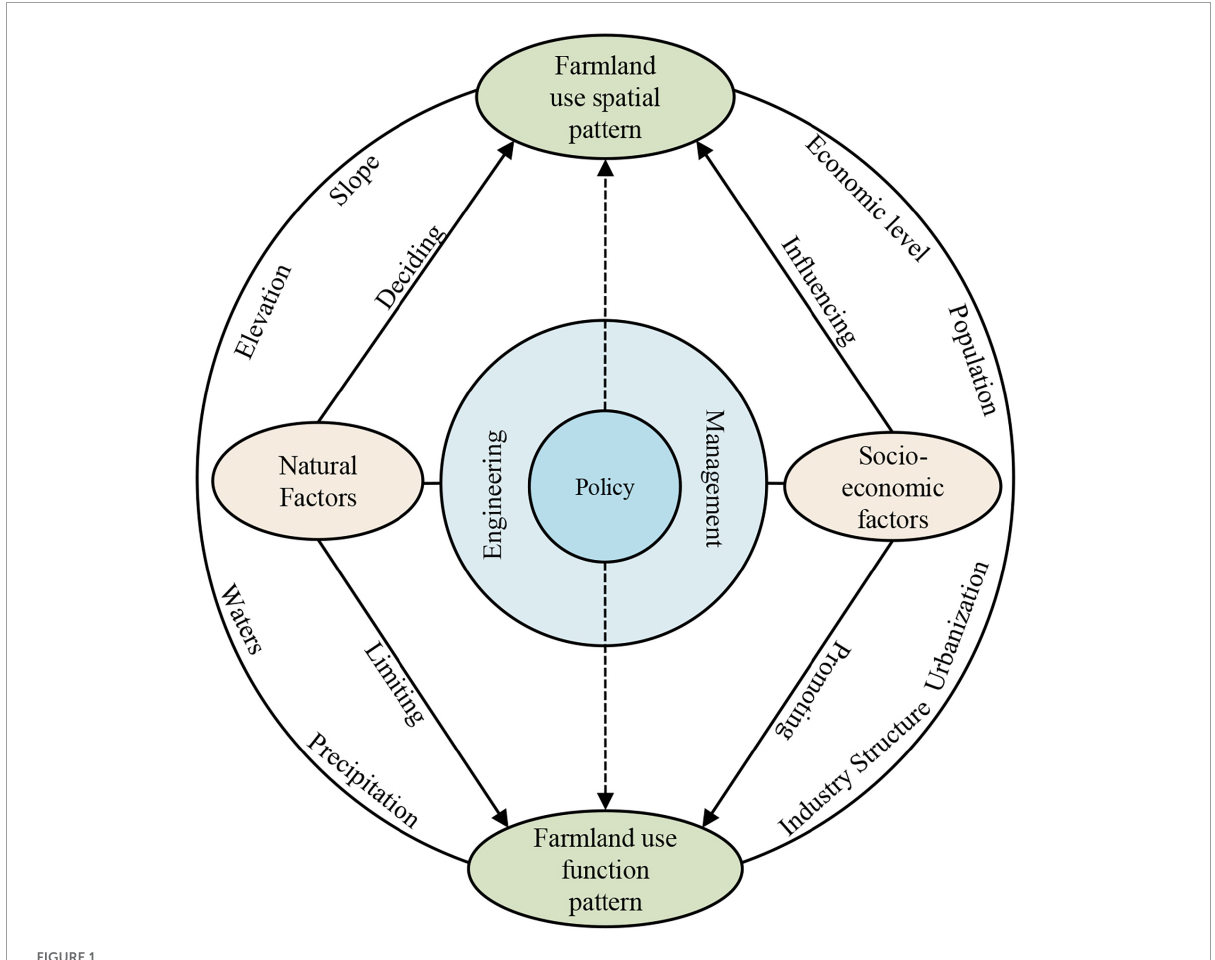
FIGURE1 Theoretical framework of farmland use